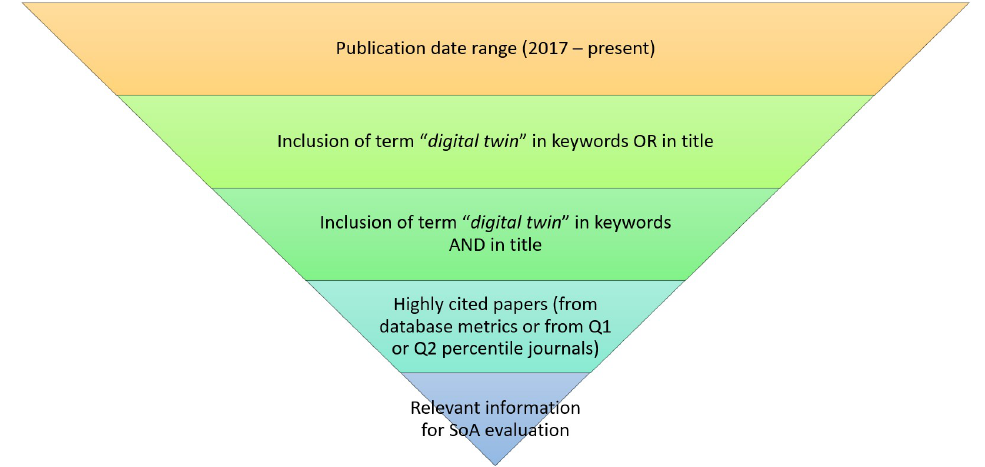
Figure 1. Selection criteria process for publication comparative analysis